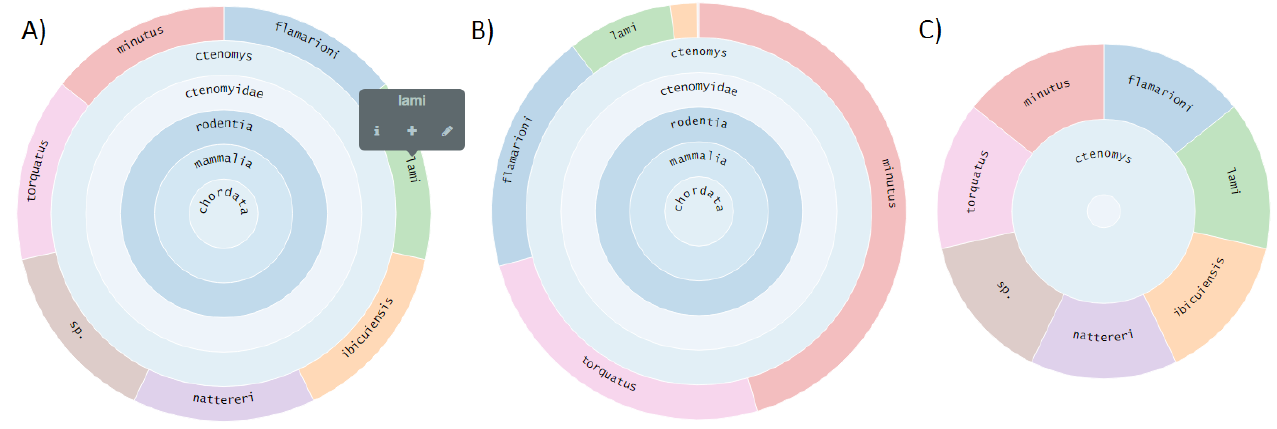
Figure 3. Examples of Sunburst visualization with the current database information: A) initial Sunburst layout, partitioned by the number of taxa and hovered on the lami partition, showing its tooltip; B) Sunburst layout when partitioned by specimens; C) Sunburst partitioned by taxa when zoomed on the Ctenomys taxon.